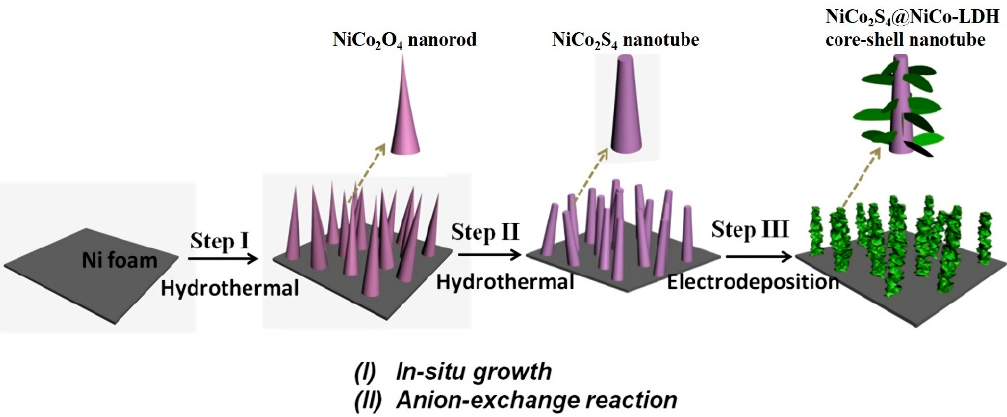
Figure 1. Schematic illustration of formation of NCS@NCOH NTAs on Ni foam.